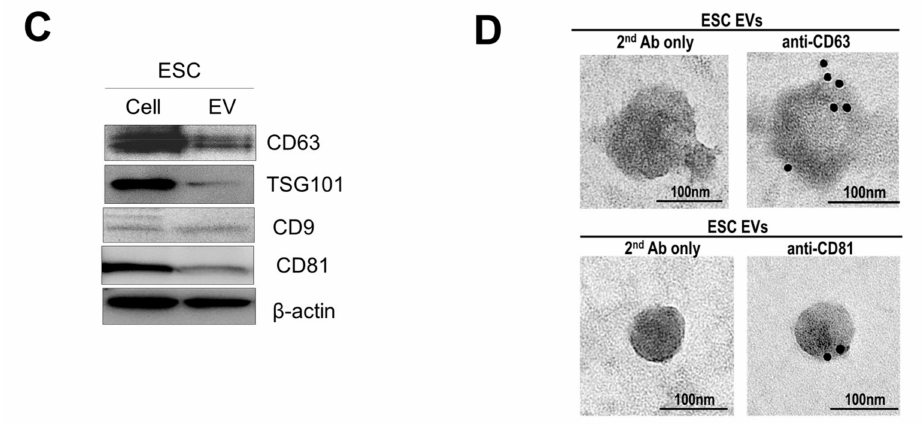
Figure 1. To examine the extracellular vesicles that exist in endometrial stromal cells by NTA (nanoparticle tracking analysis), TEM and immunoblot analysis. ( A ) Nanoparticles were illuminated by the laser; their movement under Brownian motion was captured for 60 s, and the video recorded was subjected to NTA using the Nanosight particle tracking software to calculate nanoparticle concentrations and size distribution. Blue numbers mean the size(nm) of extracellular vesicles. ( B ) The isolation of extracellular vesicles derived from endometrial stromal cells and villi tissues by ultra-centrifuge. In (TEM) observation, the size of ESC-extracellular vesicles was 50–150 nm. ( C ) The extracellular vesicles supernatant was denatured in 4x sodium dodecyl sulfonate (SDS) buffer and subjected to Western blot analysis using rabbit antibody CD63, CD9, CD81 and TSG101. beta-actin served as a control. ( D ) CD63 and CD81 positive dots of extracellular vesicles were analyzed by TEM and